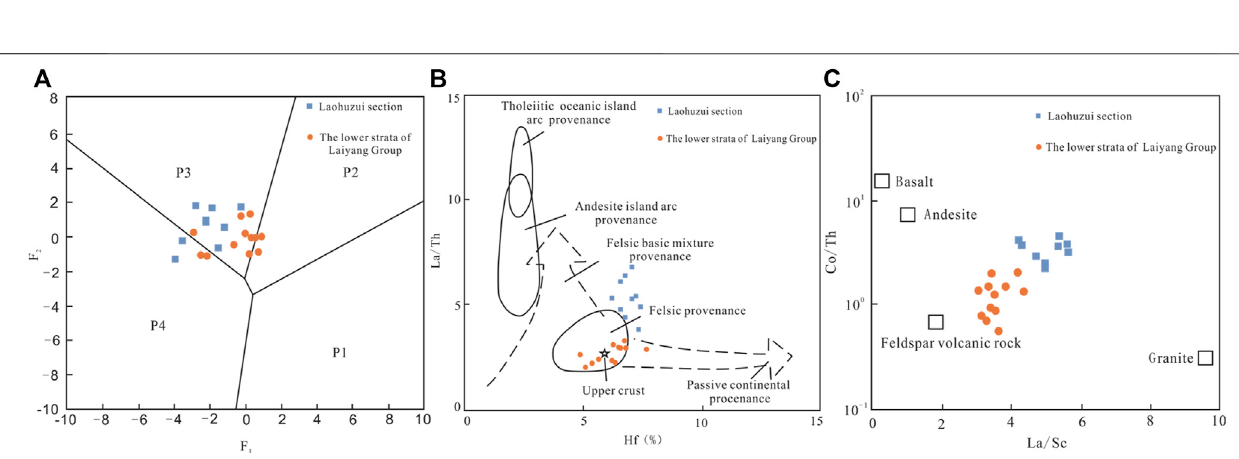
( Table 2 ). The contents of elements in the Laohuzui section sandstone were compared with the relevant parameters in an oceanic island arc, continental island arc, active continental margin, and passive continental margin. The results showed